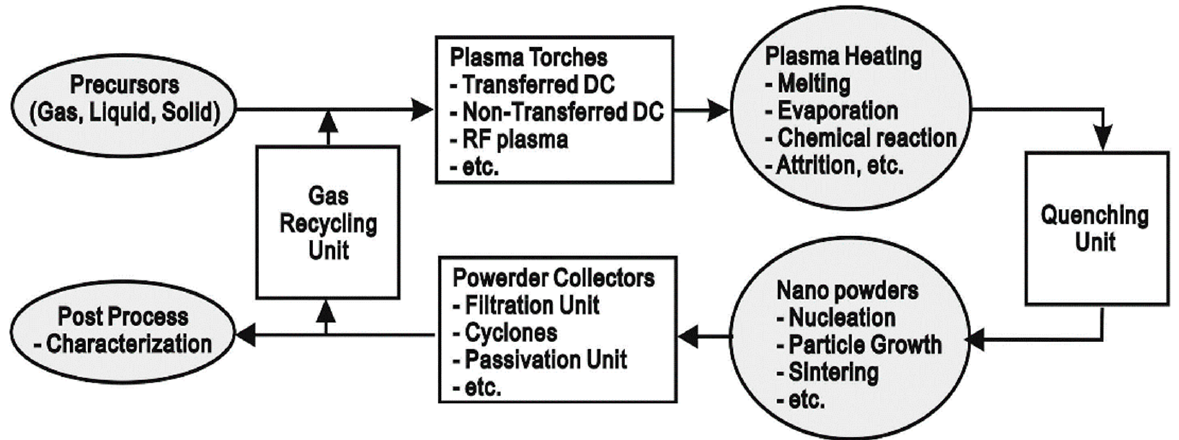
Figure 3. Thermal Plasma Synthesis Procedure for the Production of Nano-sized Powders. Reproduced from Ref. [11], an open access article.